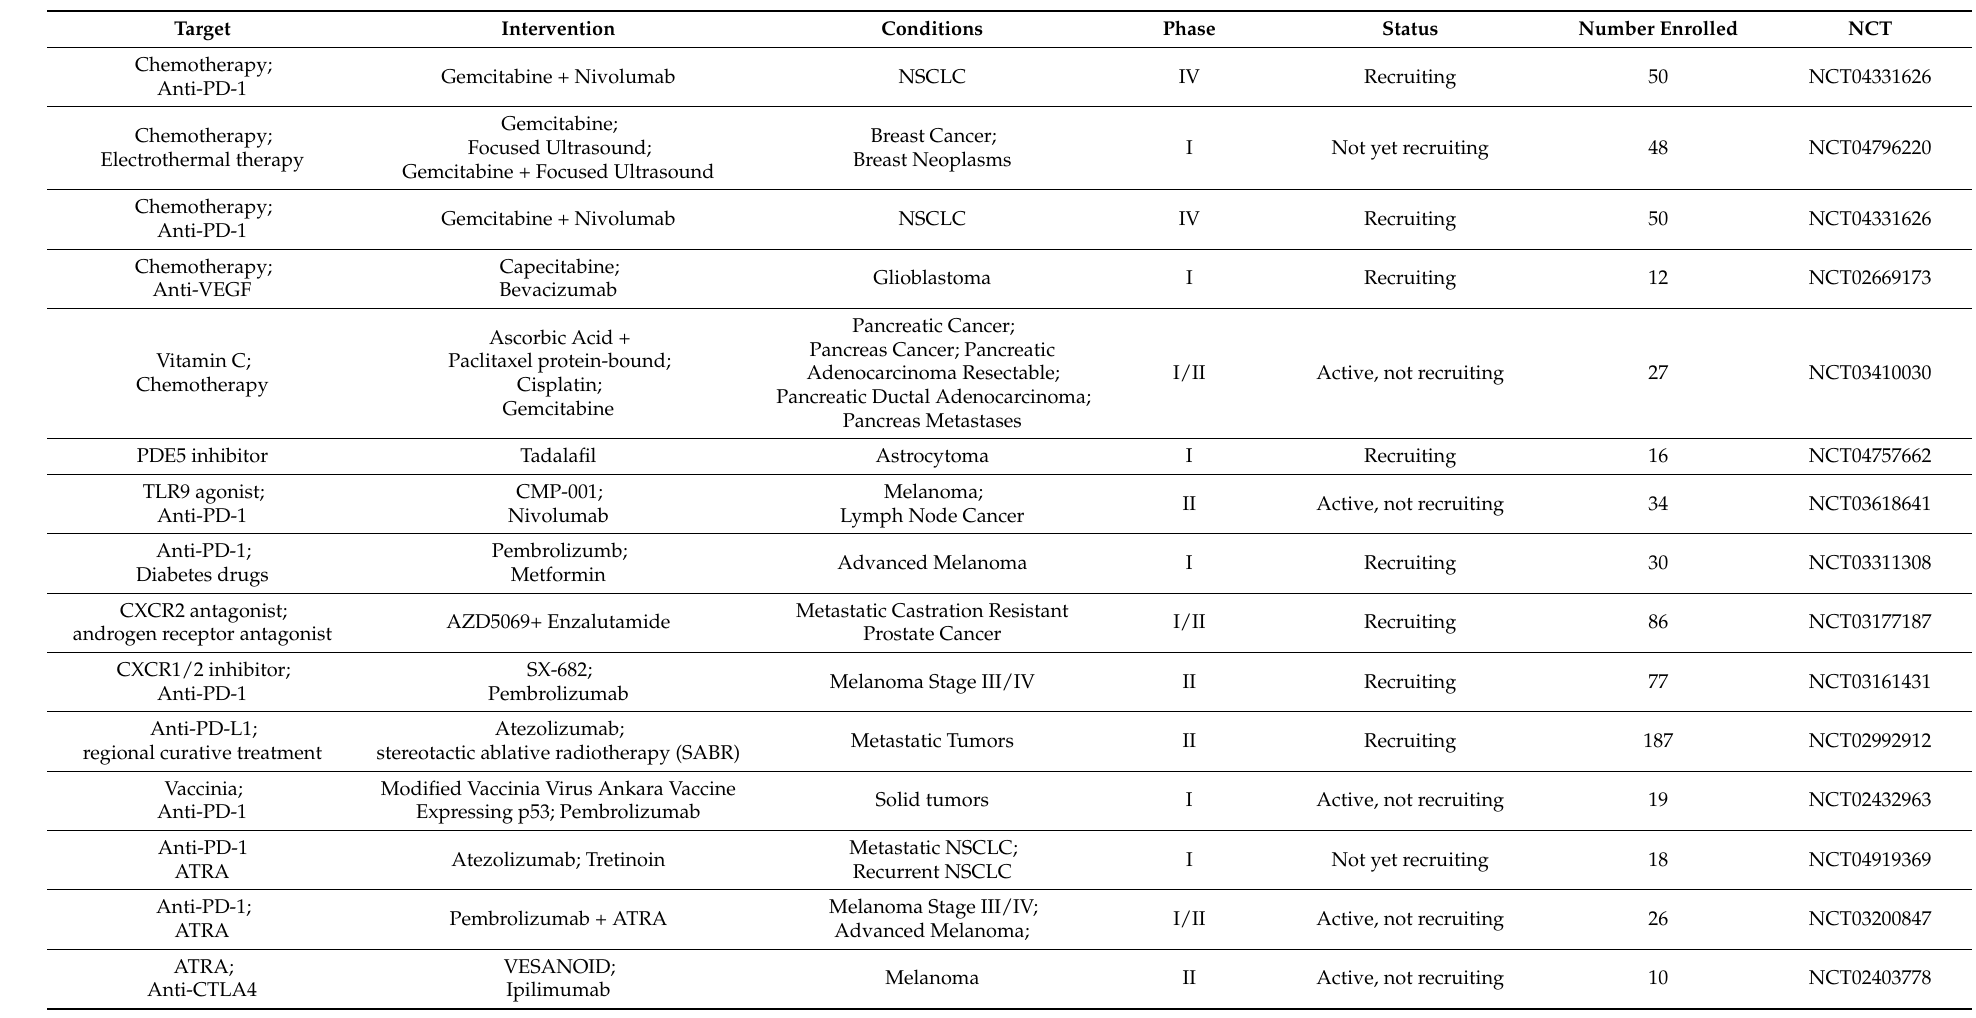
Table 2. Clinical trials of targeting MDSCs in solid tumors (recruiting, active, or